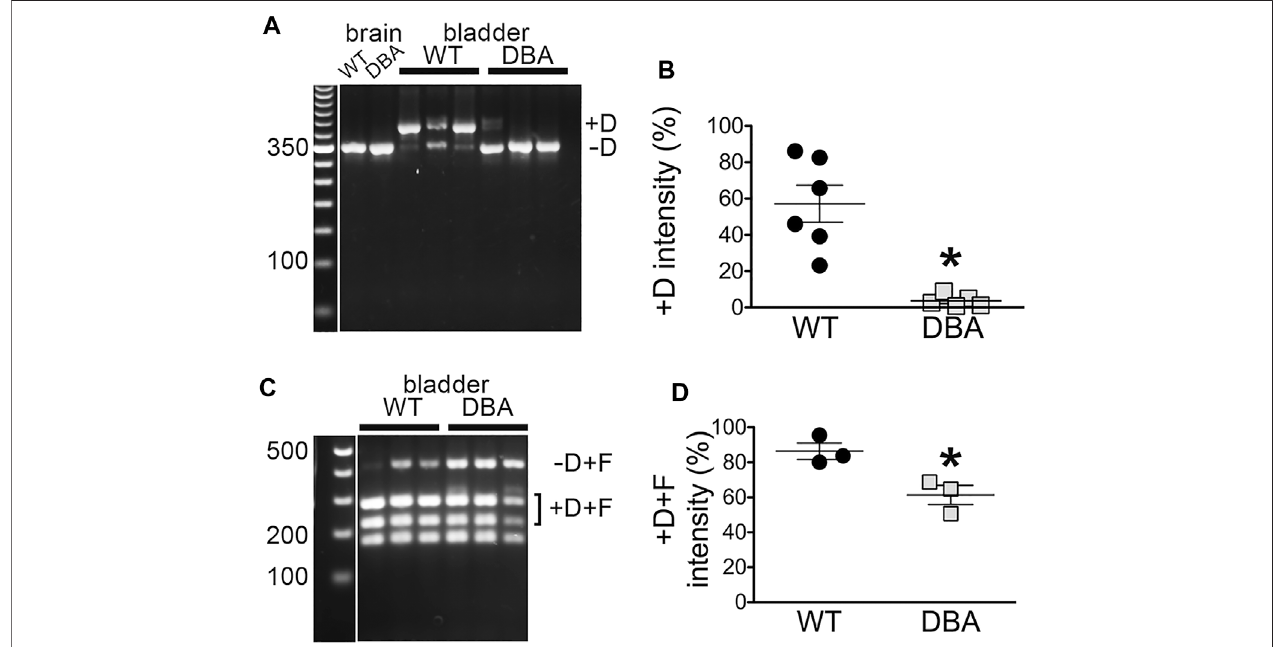
FIGURE 6 | Myo5a exons D and F in bladders from WT and DBA mice. (A) Nested PCR fragments from detrusors of WT ( N = 6) and DBA ( N = 5) animals were preparedwithprimerpair3andelectrophoresed.ArepresentativeagarosegelwithbandscorrespondingtofragmentswithandwithoutexonDfromthreeWTandthree DBA detrusors is shown, with individual WT and DBA brain samples as controls. Exposure of the 50 bp standard lane, with weighted 350 bp band, was adjusted separately. (B) The intensity of +D bands is graphed as a proportion of total intensity in each lane (sum of +D and − D) and plotted for WT (black circles), and DBA (gray squares). Horizontal line indicates average intensity in % ± SEM for the +D band in all replicates. The comparison between WT and DBA detrusor was signi fi cant (* p =0.015). (C) Nested PCR fragments from detrusor ofthree WT and three DBA animalswere prepared with primer pair 4, digested with Ban II to cleave the +D band, and electrophoresed. The relative positions of detrusor exon F-containing digestion fragments including or lacking exon D are indicated, and a fl anking lane with 100 bp standardsismarked.Contrastforthestandardlanewasadjustedseparately. (D) Dataaregraphicallyrepresented;thehorizontallineindicatesaverageintensitiesin%± SEMforPCRproductcontainingexonD(blackcircles,WT;graysquares,DBA)aregraphed.CoincidenceofexonsDandFinthesamecDNAfragmentwassigni fi cantly reduced in DBA detrusor ( p = 0.03).